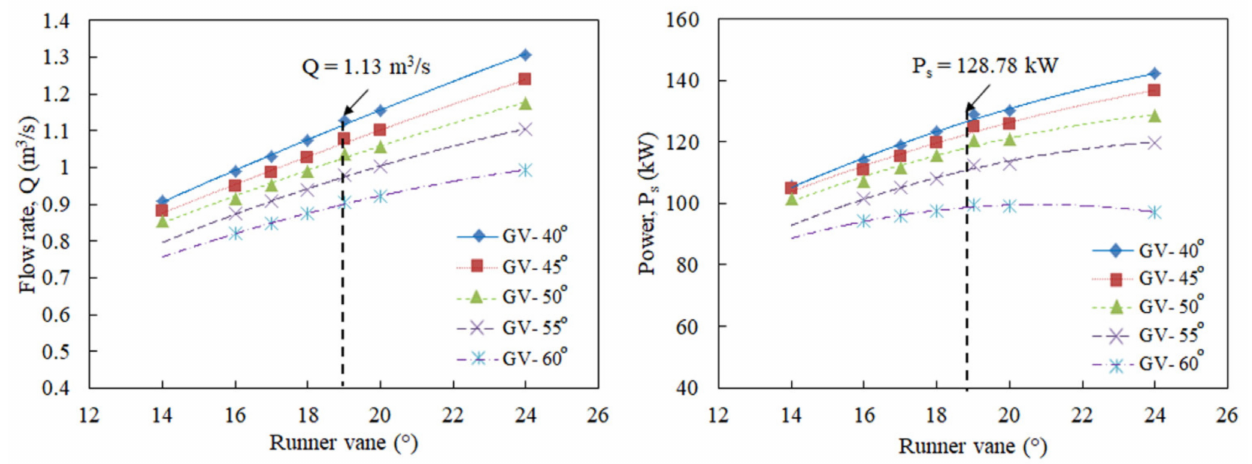
Figure 14. Flow rates, power versus runner vane, and guide vane opening angles. The rated flow rate was found when the runner vane opening angle was 19°, and the guide vane opening angle was 40°. In this case, efficiency was found to be 78.44%, and power output was 128.78 kW at a flow rate of 1.13 m 3 /s. Figure 15 shows the blade-to-blade pressure and velocity (magnitude) distributions at a 0.5 span (non-dimensional blade height = 0.5). In this figure, the dotted circle represents the leading edge and trailing edge of the runner blade. The pressure was maximum, and the velocity was minimum at the leading edge of the pressure side. Velocity was not distributed uniformly from the leading edge to the trailing edge of the runner vane. Velocity decreased at the trailing edge of the runner vane, and a small vortex formed in this region.